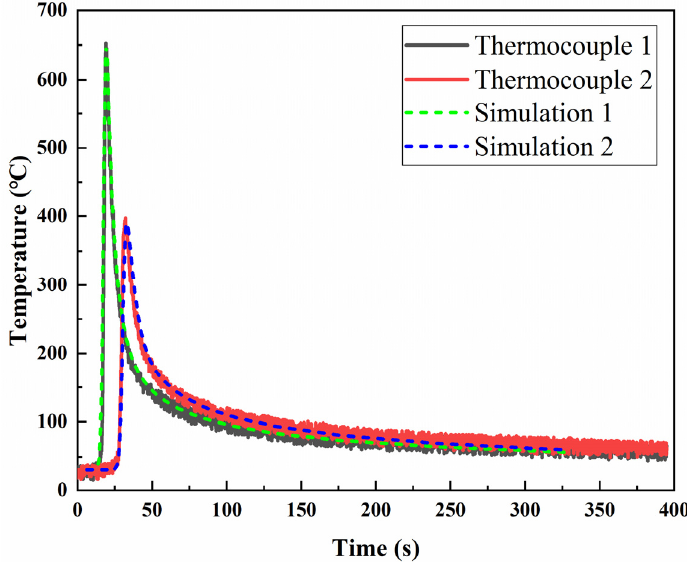
Figure 8. Comparison between simulated and experimental thermal cycle curves.